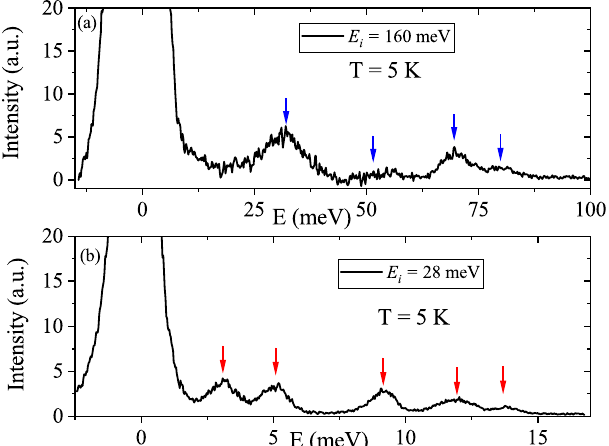
Figure 4. Powder INS spectra measured at 5K with incident energies 160meV ( a ) and 28meV ( b ) in Er10%. Arrows correspond to CF energy levels reported for Er 3 + (red arrows) [13] and Yb 3 + (blue arrows) [32] ions in parent compounds SrEr 2 O 4 and SrYb 2 O 4